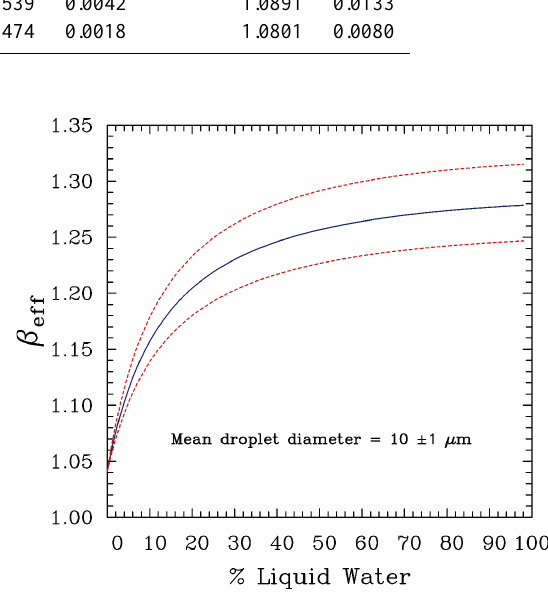
Fig. 7. Dependence of the retrieved liquid water fraction on β eff and the sensitivity of the retrieval on the assumed mean cloud droplet size. The blue curve is for a mean size of 10µm, while the two red dashed curves are for mean droplet sizes of 9 (lower) and 11